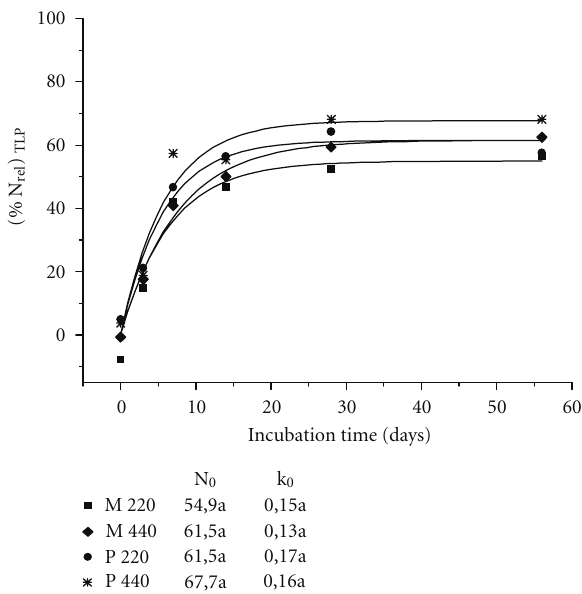
Figure 2: Percentage of the net cumulative N released by TLP into M and P soils. The N 0 or k 0 values followed by the same letter are not significantly di ff erent at α = 0 . 05.